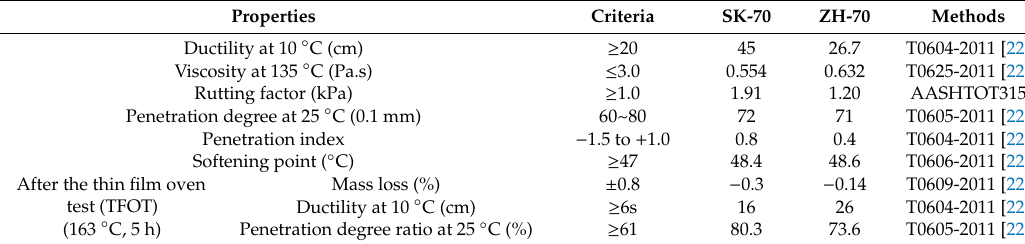
Table 2. Properties of base